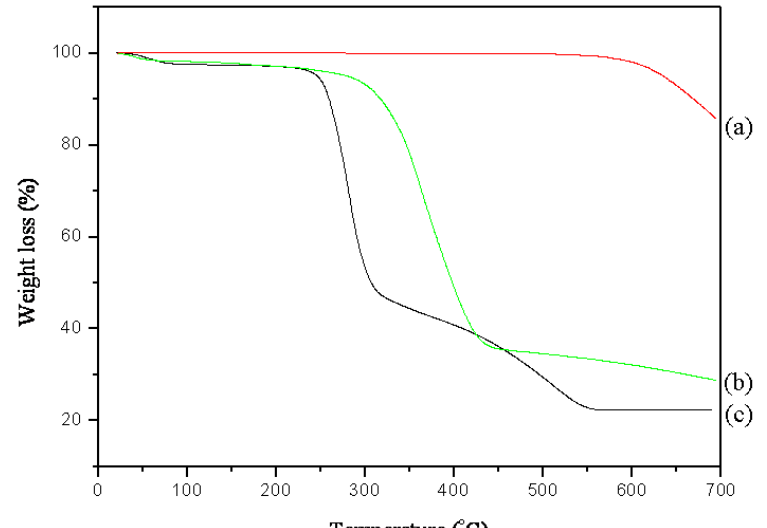
Figure 3. TGA curves of the purified MWNT (a), poly(GMA)-g-MWNT (b) and MWNT ionic liquid